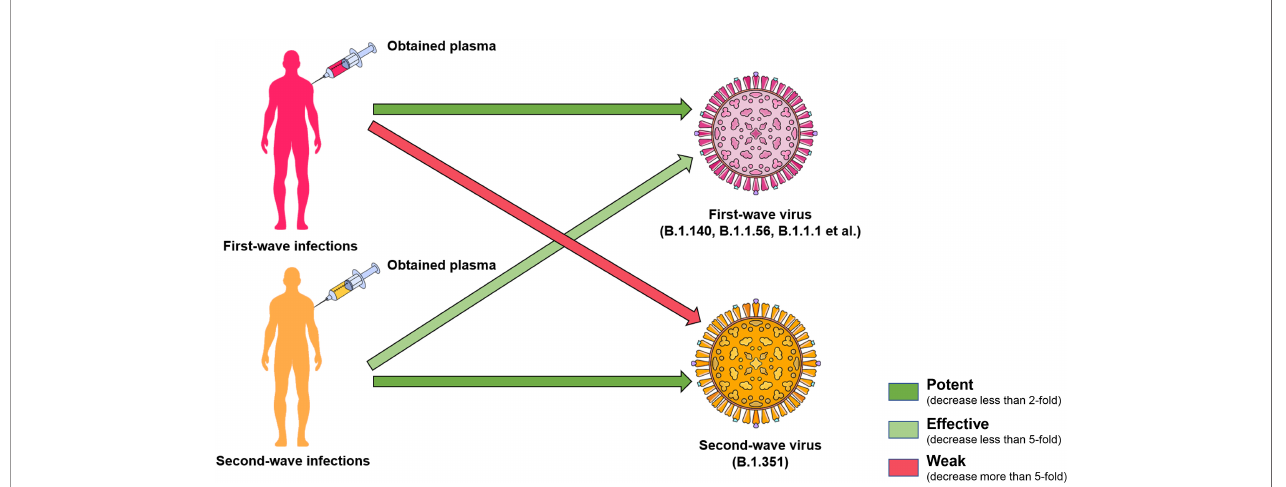
FIGURE 5 | Cross neutralization of convalescent plasma. The cross neutralization of convalescent serum has been noticed by the neutralization activity test. The convalescent serum from B.1.351-infected patients retained the neutralization against the virus in the fi rst-wave epidemic in South Africa. However, the serum obtained from the fi rst-wave of epidemic infection could not effectively neutralize B.1.351. The green arrow indicates that the neutralization still remains, and the light green means a worse neutralization effect. Pink indicates a signi fi cant decrease in neutralization ef fi